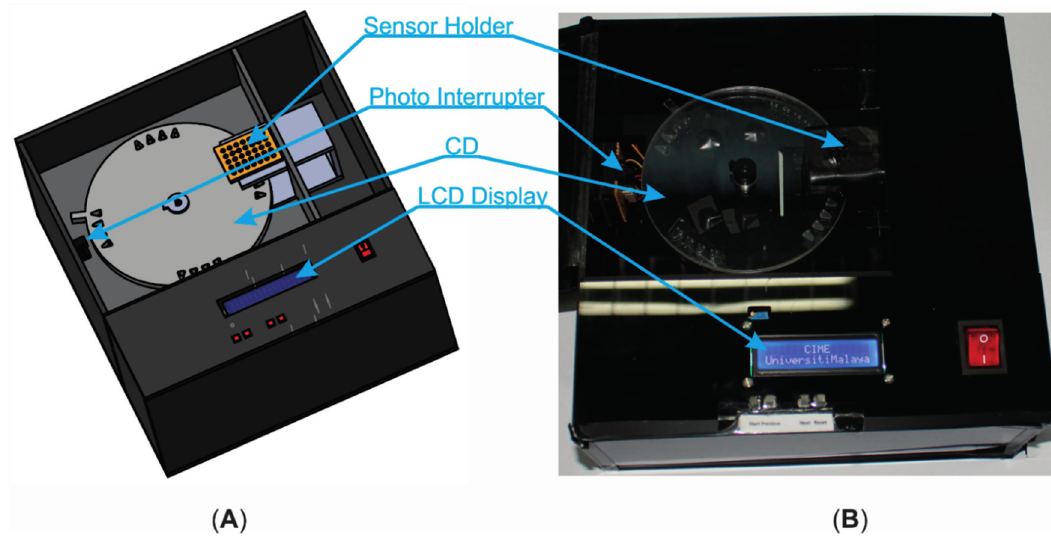
Figure 3. Endpoint detection system ( A ) Schematic illustration in 3D; ( B ) Photograph of the operating model.